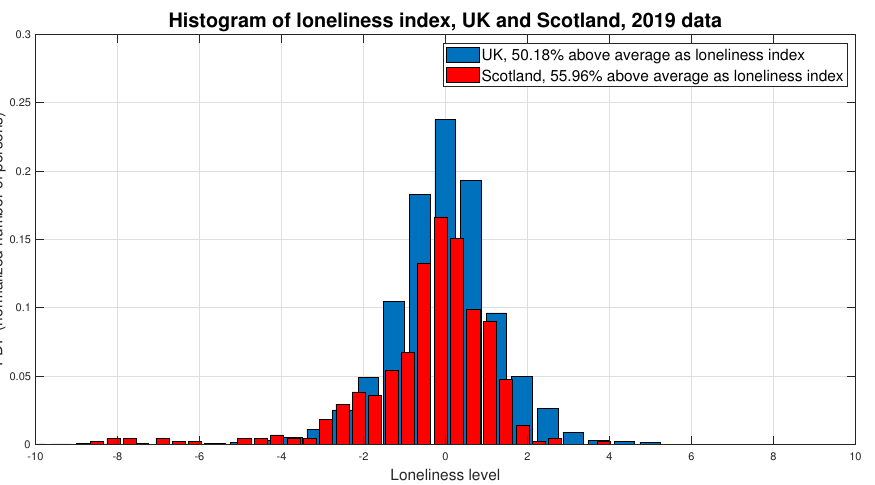
Figure 2. Examples of loneliness indices based on 2019 open-access